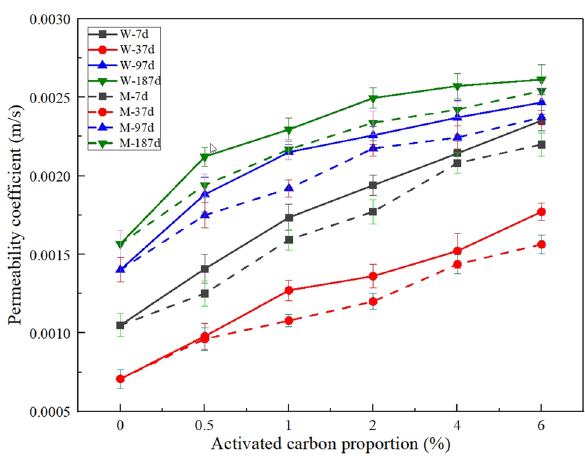
indicate significant differences between different activated carbon proportions ( P < 0.05).